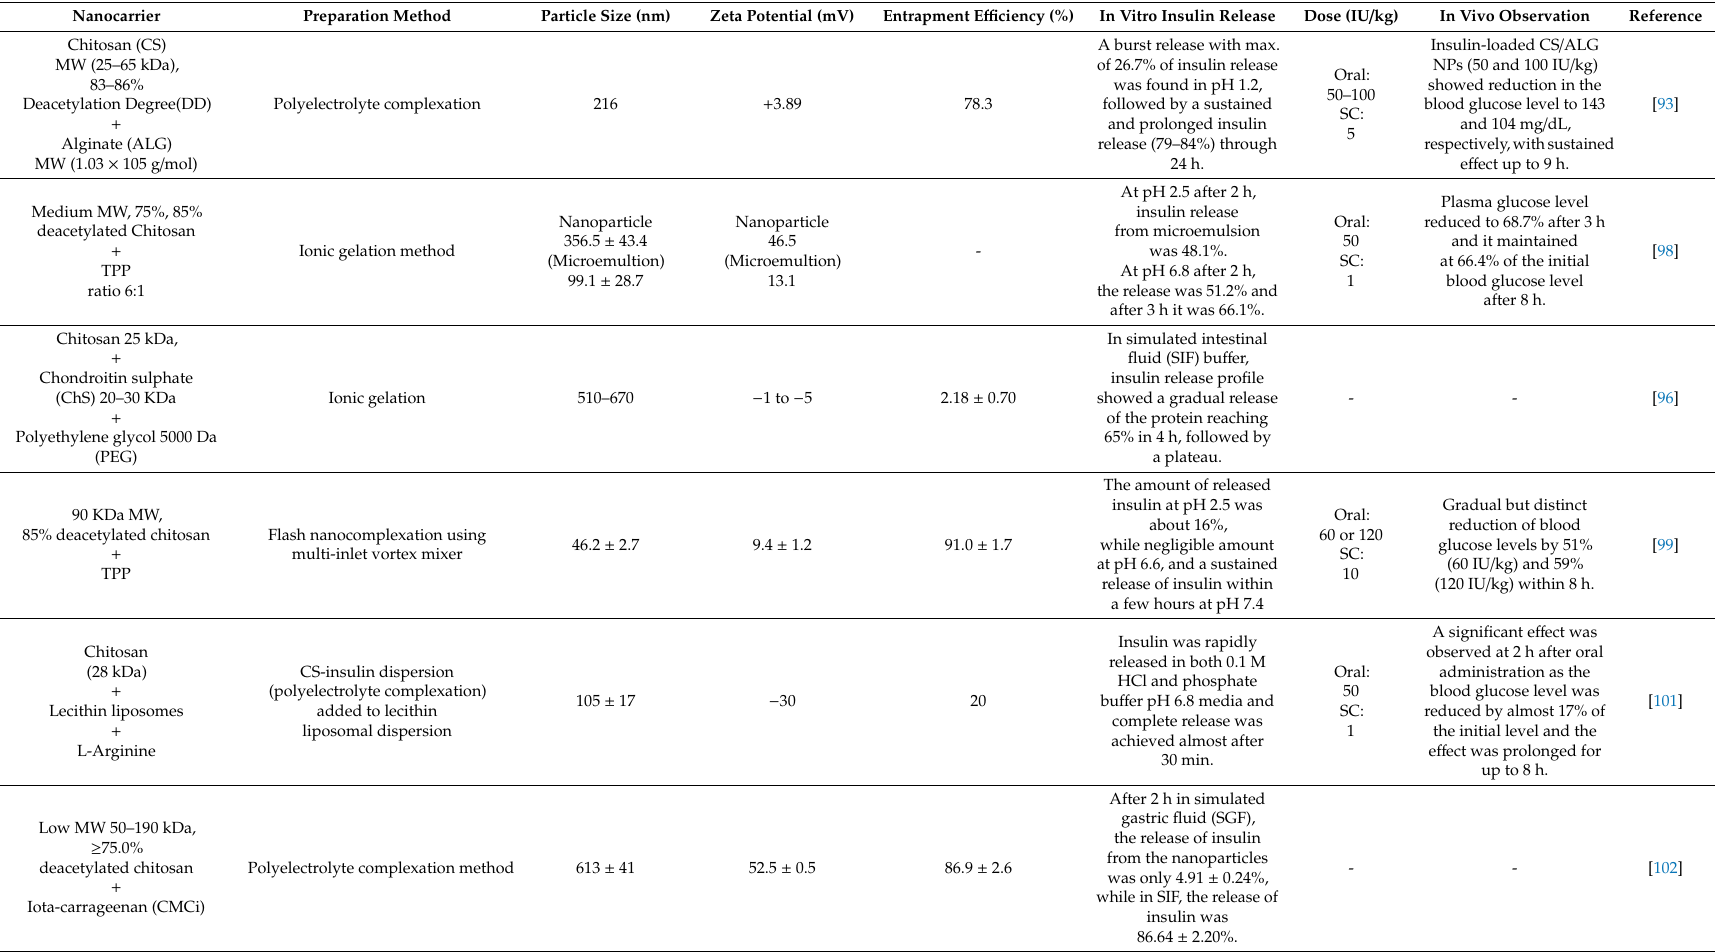
Table 2. Examples of chitosan-based nanoparticles-loaded